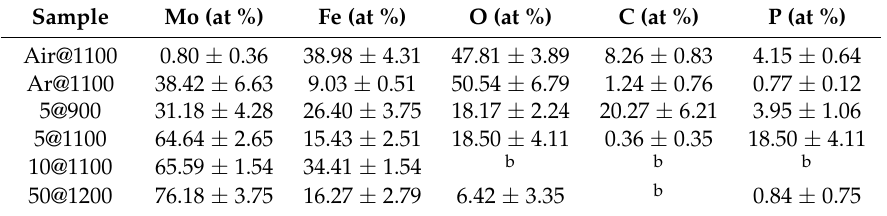
Table 2. Summary of elemental composition as determined by EDX a .